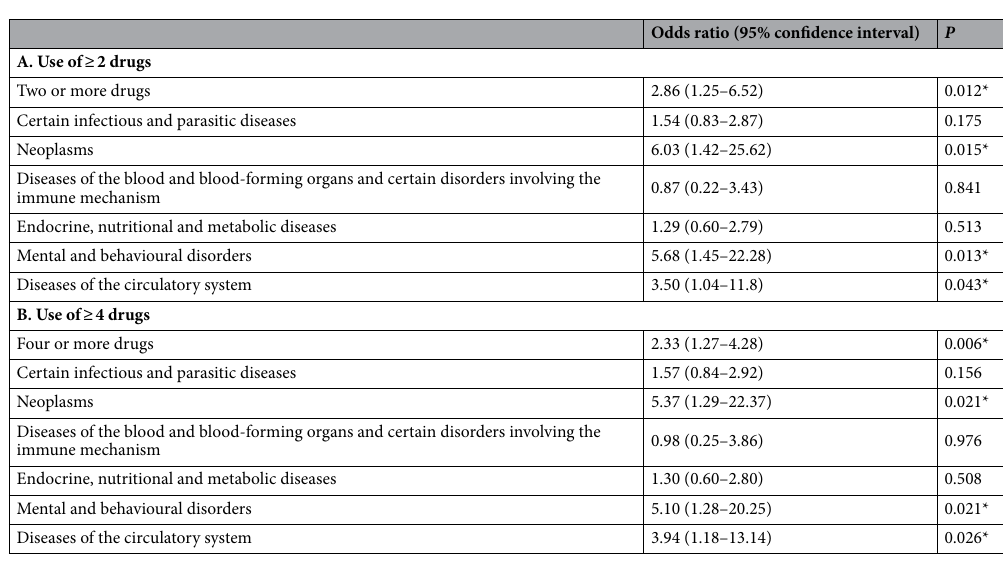
Table 5. Multivariate analysis. Multiple logistic regression analysis. * P <